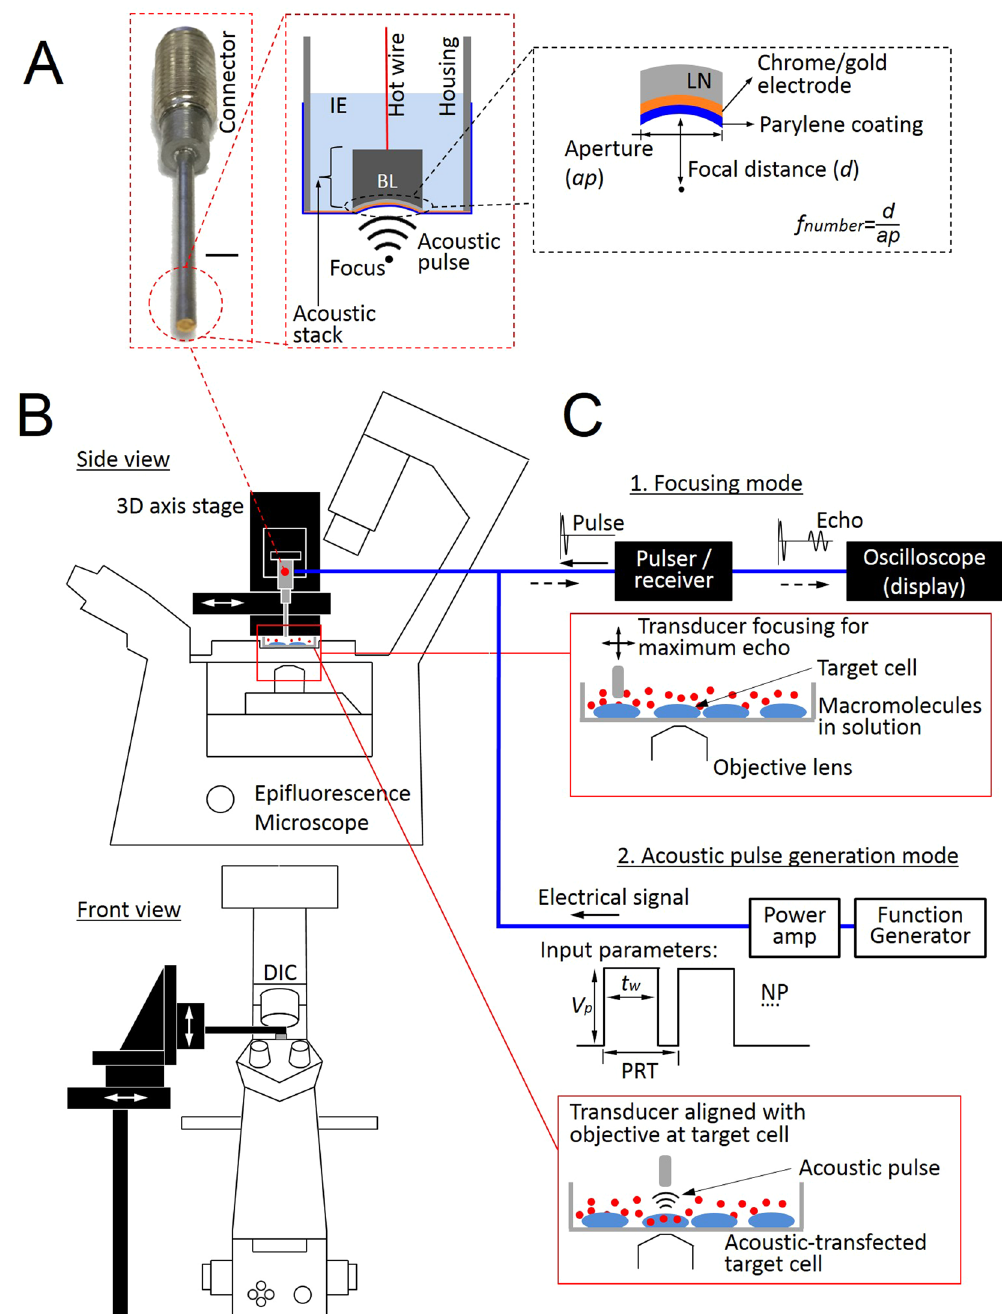
Figure 1. Acoustic-transfection system. ( A ) Schematic diagram of an acoustic-transfection system and a high frequency ultrasonic transducer. ( B ) A 3D axis stage was integrated with epifluorescence microscope to precisely control the location of a high frequency ultrasonic transducer (grey color). The high frequency ultrasonic transducer was mounted on a 3D axis stage. The 3D axis moves in the x, y, and z directions in 0.3 μ m increments. A petridish that contained cells and solution with macromolecules were placed on the epifluorescence microscope stage for acoustic-transfection. ( A ) A photograph of a high frequency ultrasonic transducer, used in this study, is shown in the first dashed rectangle (Scale bar, 2 mm). An acoustic stack consisting of a conductive backing layer, BL, and lithium niobate, LN, generated an acoustic pulse to treat cells by the excitation of an electrical signal, transmitted through hot wire. The aperture, ap , is the diameter of the LN. The acoustic stack was placed at the tip of the housing and fixed with insulating epoxy, IE, and spherically focused to a focal distance, d . The chrome/gold layer in front of the LN is for the ground connection. A parylene coating is used for protection from corrosion. ( C ) A target single-cell for acoustic-transfection is selected by the epifluorescence microscope using an appropriate objective lens. The ultrasonic transducer was connected to a pulser/receiver and an oscilloscope (display) to place the focus of the ultrasonic transducer at the target